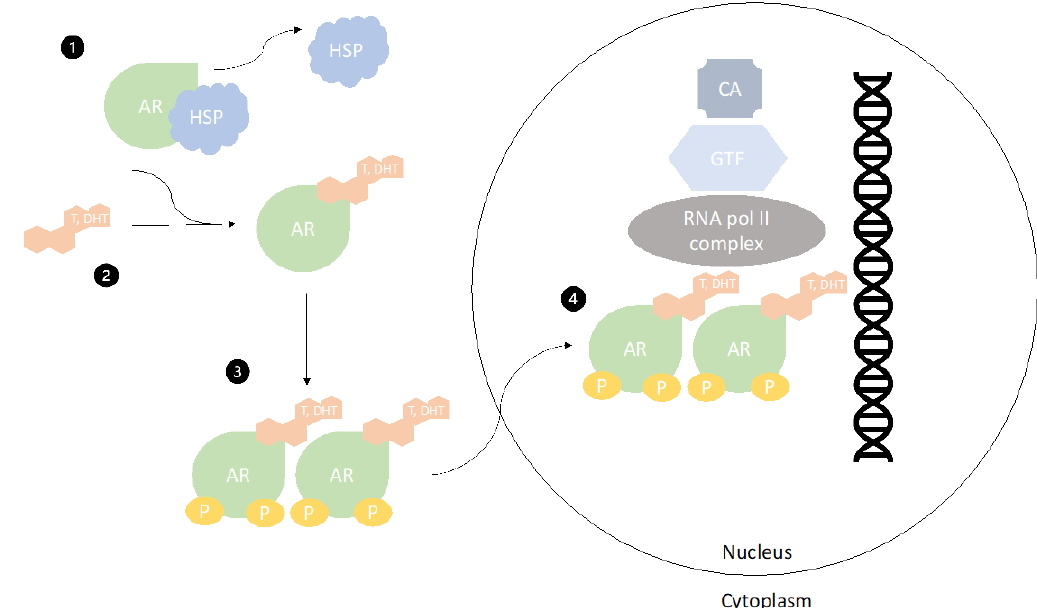
Figure 1. Mechanism of androgen receptor (AR) activation. Figure 1 represents how AR is activated by testosterone or dihydrotestosterone in a cell. 1 . When AR is inactive, it is bound to heat-shock proteins (HSP). 2 . Circulating androgens (e.g., testosterone and dihydrotestosterone) bind to C terminal ligand-binding domain and cause a conformational change of AR, displacing HSP. 3 . Afterwards, dimerization of AR and phosphorylation of its tyrosine kinases occurs. This change causes 4 . translocation of the complex to the nucleus where a DNA binding complex binds to androgen-responsive elements and transcription complex is formed. AR—androgen receptor HSP—heat-shock protein T; DHT—testosterone, dihydrotestosterone; P—phosphate group RNA pol II complex—RNA polymerization complex; GTF—general transcription factors;